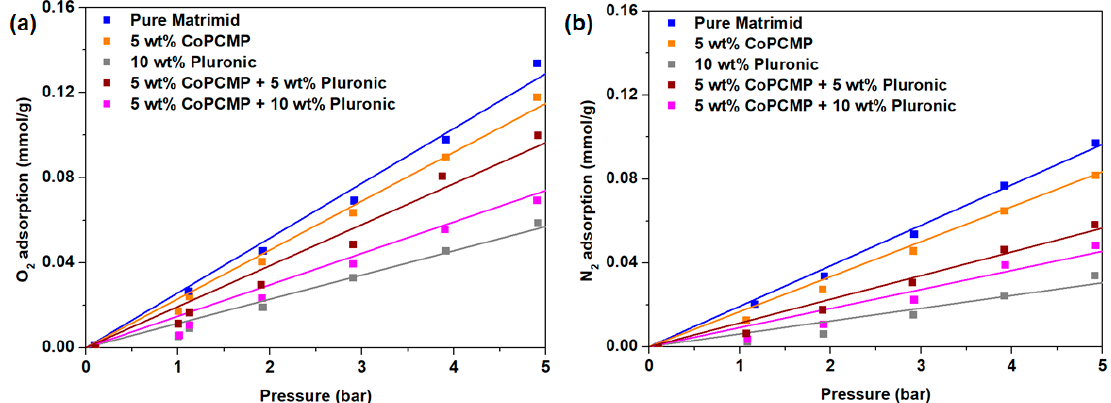
Figure 5. ( a ) O 2 and ( b ) N 2 adsorption of neat (Matrimid), blended (Matrimid-Pluronic), and composite (Matrimid-CoPCMP and Matrimid-CoPCMP-Pluronic) membranes at 35 ◦ C at di ff erent pressures. Table 2. Solubility and di ff usivity data for neat (Matrimid), blended (Matrimid-Pluronic), and composite (Matrimid-CoPCMP and Matrimid-Pluronic CoPCMP) membranes. Membrane